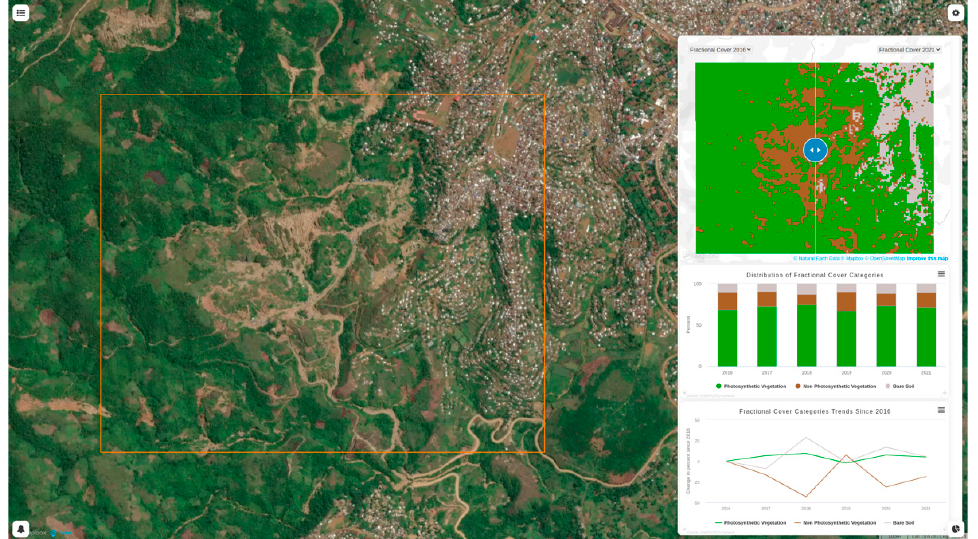
Figure 1. Screenshot of the MapX layer developed for the study area covering the Bipasi and Kazibe mines. Kazibe